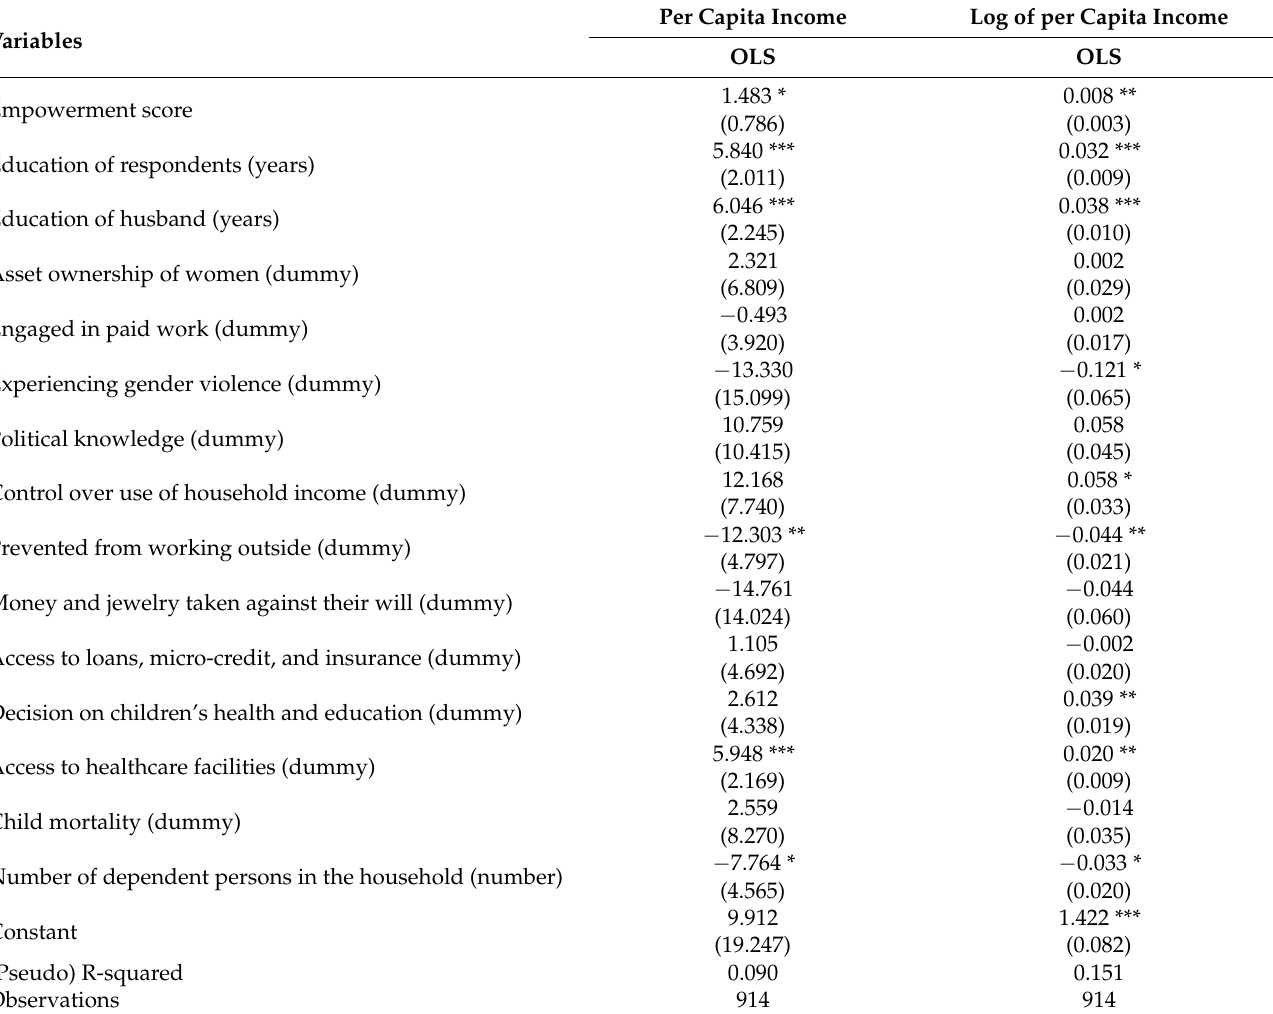
Table 5. Effect of women’s empowerment on per capita